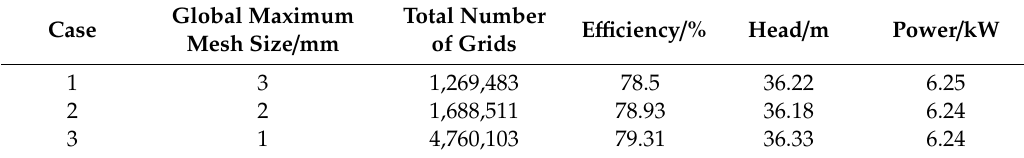
Table 2. Analysis of the grid independent.